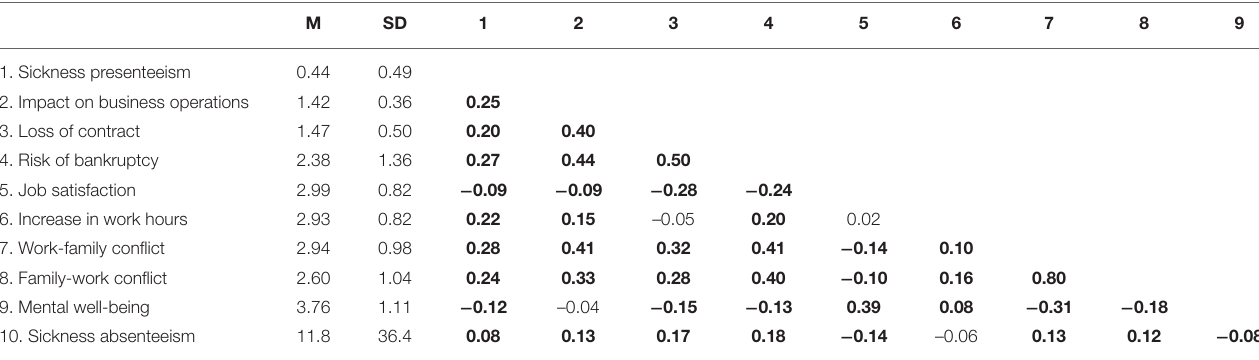
TABLE 2 | Means, standard deviations, and correlations (Pearson) between sickness presenteeism and indicators of business, work and family and